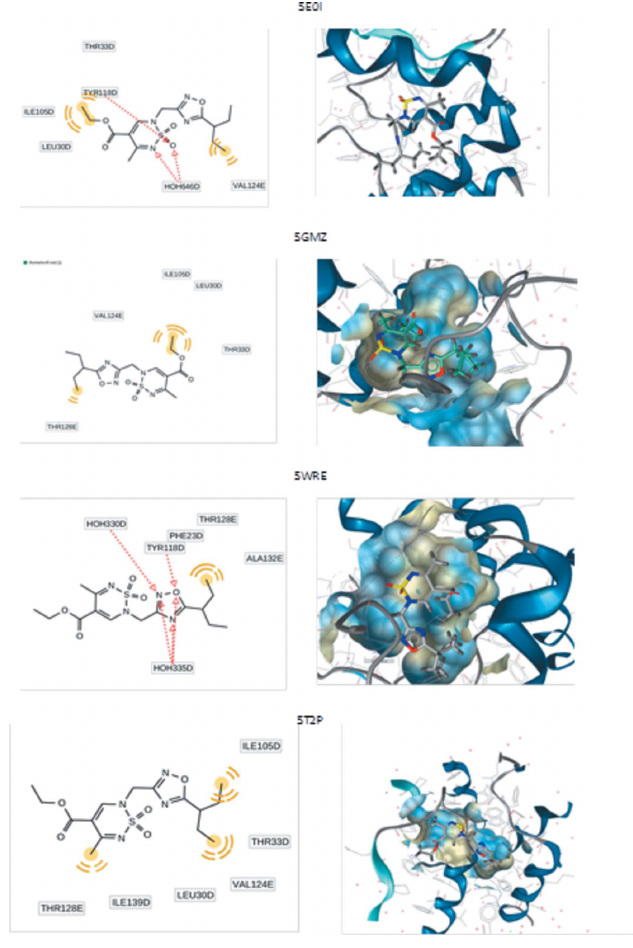
Figure 7 Calculated docking poses for the complex ‘title molecule–protein’.